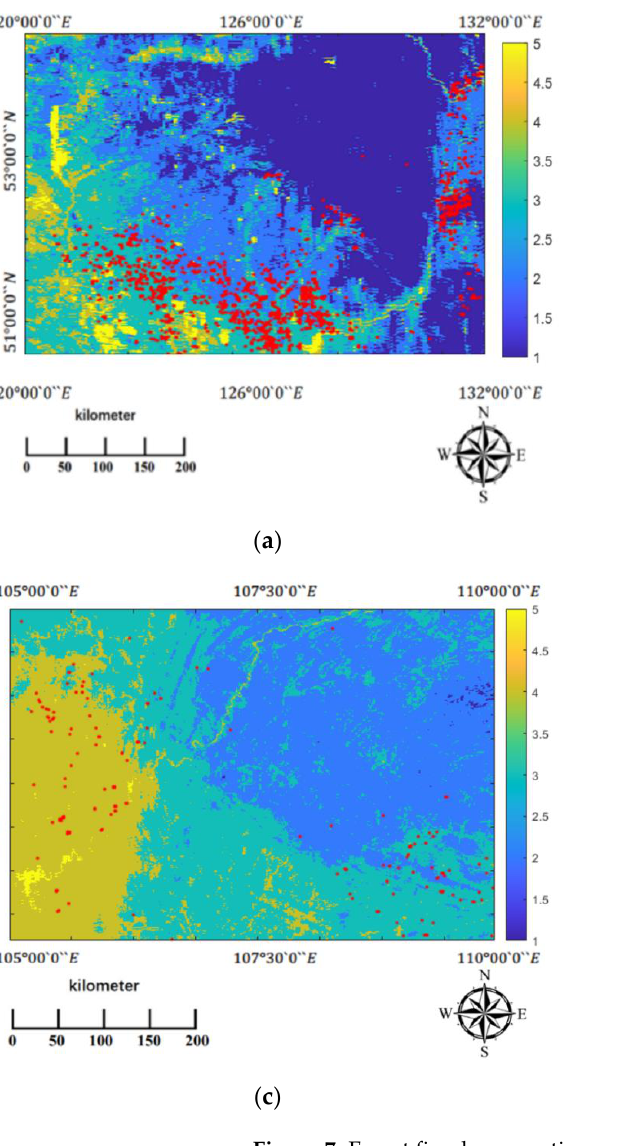
Figure 7. Forest fire danger rating map constructed by the logistic regression model: ( a ) forest area in the southern Greater Khingan Mountains; ( b ) forest area near Hulunber city; ( c ) forest area near Chongqing city; ( d ) forest area near Tongliao city.